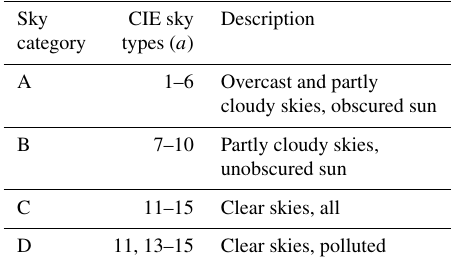
Table 1. Sky categories derived to propagate error in the CIE sky models through the sky-LOSA algorithm computing soot mass col- umn